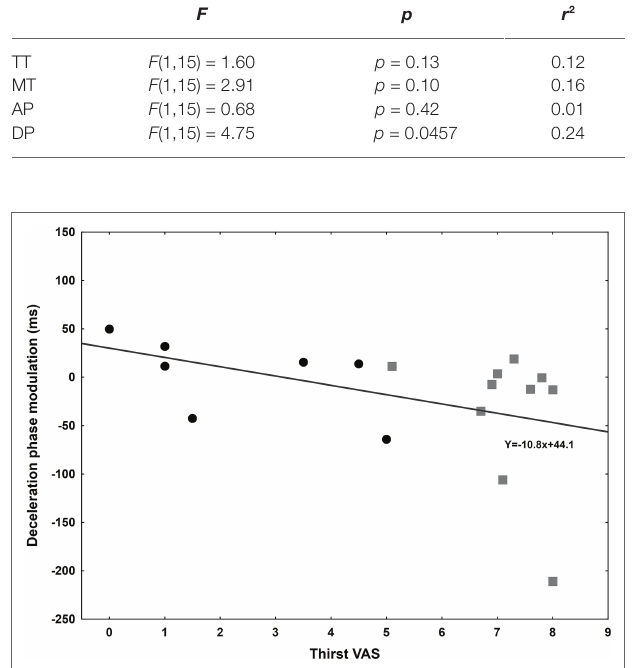
FIGURE 5 | Correlation between Thirst’s Visual Analogical Scale at the end of the experiment and the deceleration phase modulation (ms) between control (black circle) and thirsty (gray square) groups. The more important the thirst is; the shortened this phase is for a goal-directed movement towards the glass filled with water.